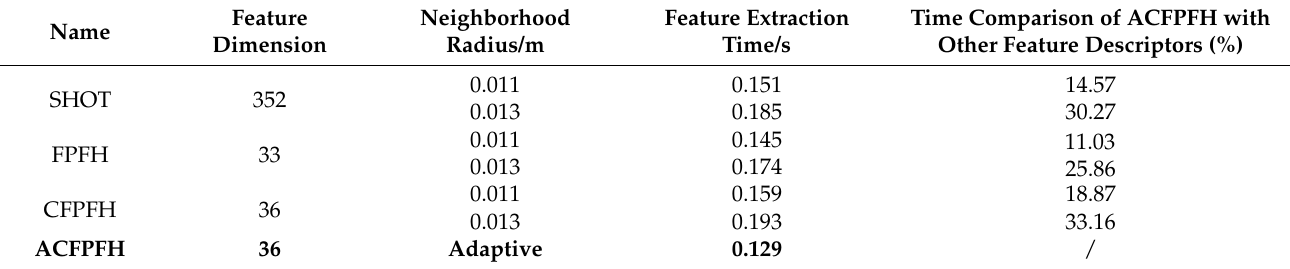
Table 3. Feature extraction time comparison of different feature descriptors.